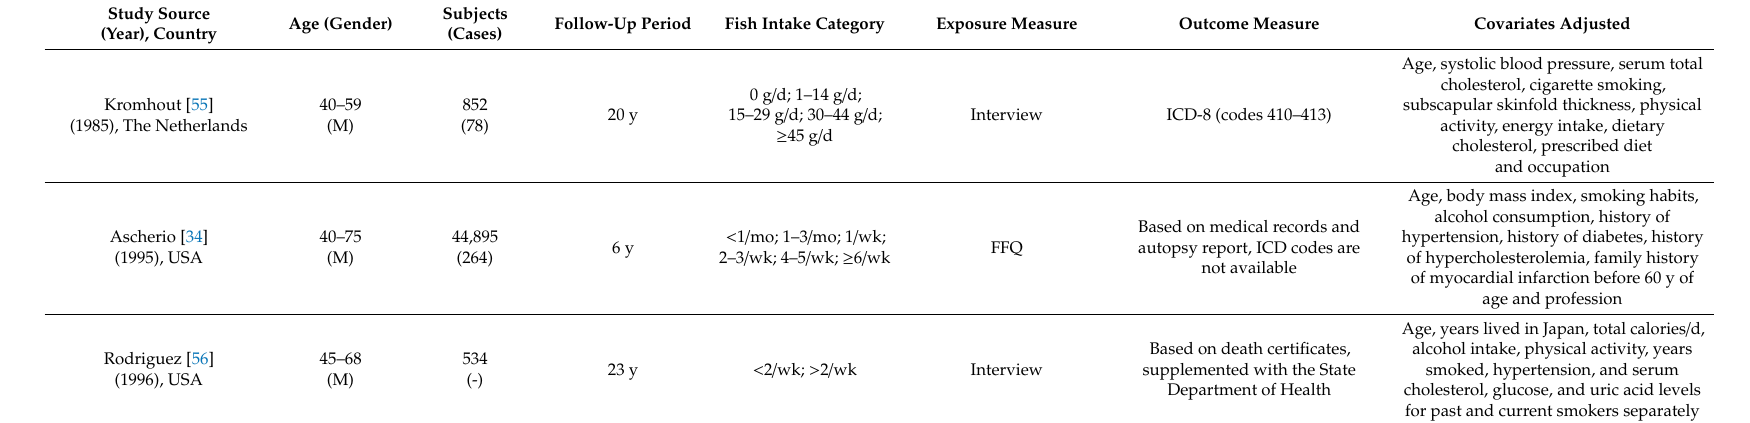
Table 2. Characteristics of cohort studies included in the meta-analysis of fish consumption and CHD